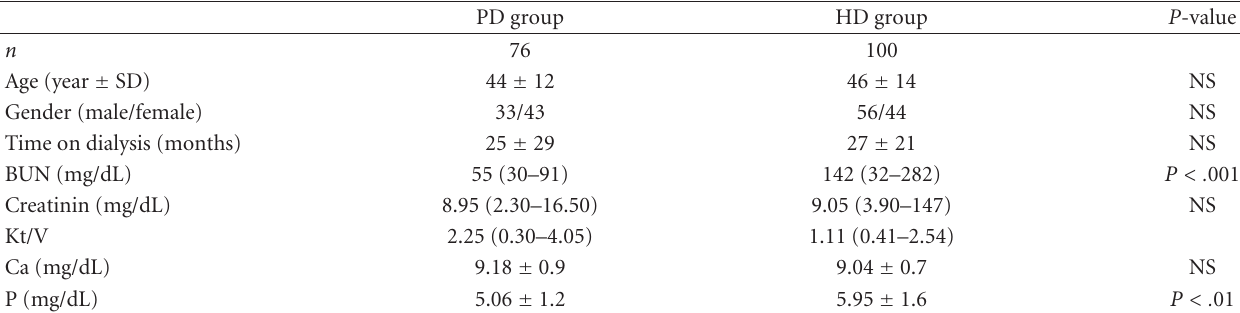
Table 1: Distribution of age, gender, and time on dialysis and laboratory findings among PD and HD groups.